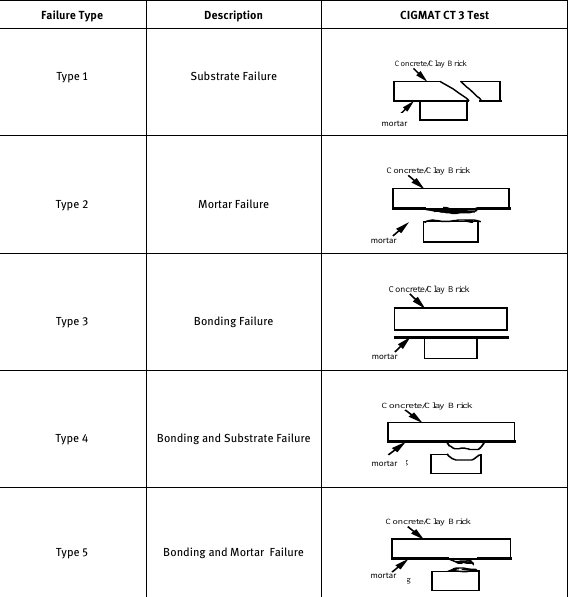
Table 5: Failure Types according to CIGMAT CT 3 standard [29,